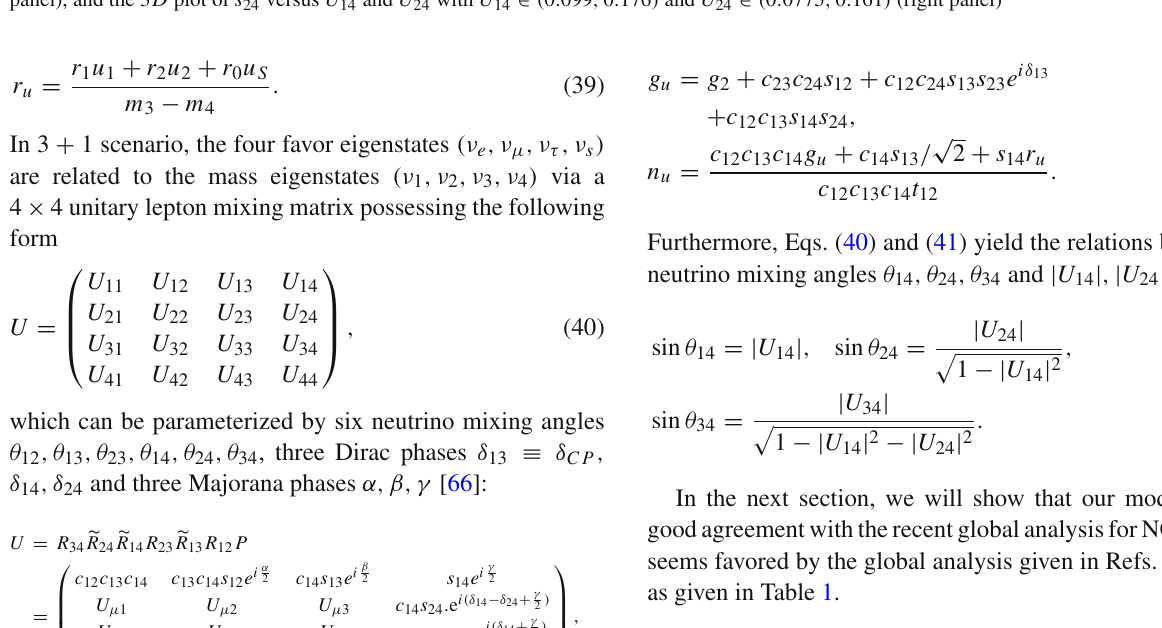
Fig. 1 U 14 − U 24 lines corresponding to the specific values s 24 = 0 . 08 , 0 . 09 , 0 . 10 , 0 . 11 , 0 . 12 , 0 . 13 , 0 . 14 , 0 . 15 and 0 . 16 from left to right (left panel), and the 3 D plot of s 24 versus U 14 and U 24 with U 14 ∈ ( 0 . 099 , 0 . 176 ) and U 24 ∈ ( 0 . 0775 , 0 . 161 ) (right